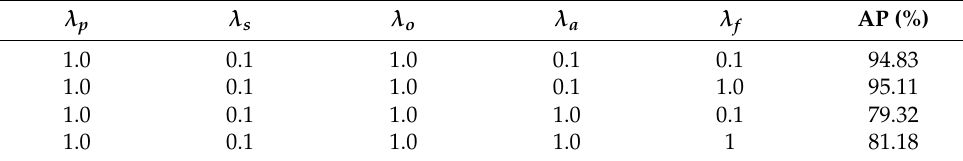
Table 7. Experimental results on different weight